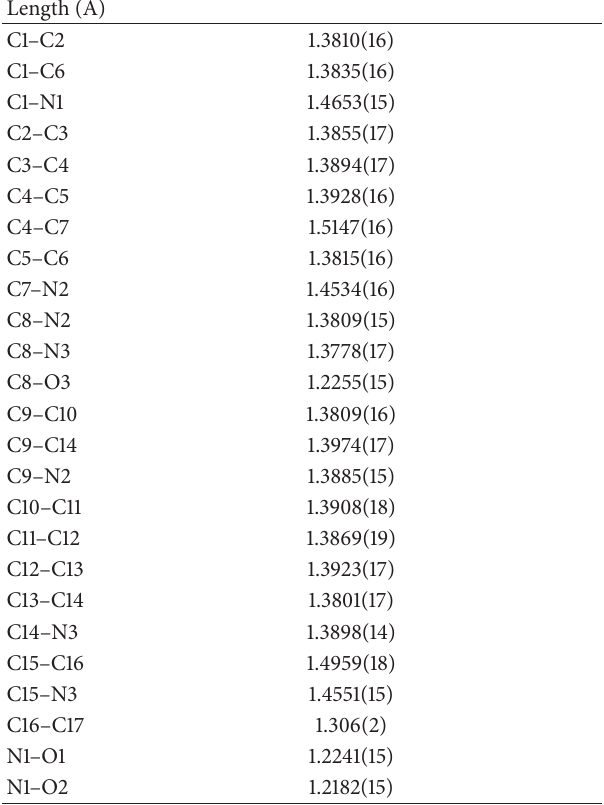
Table 2: Bond lengths for 5